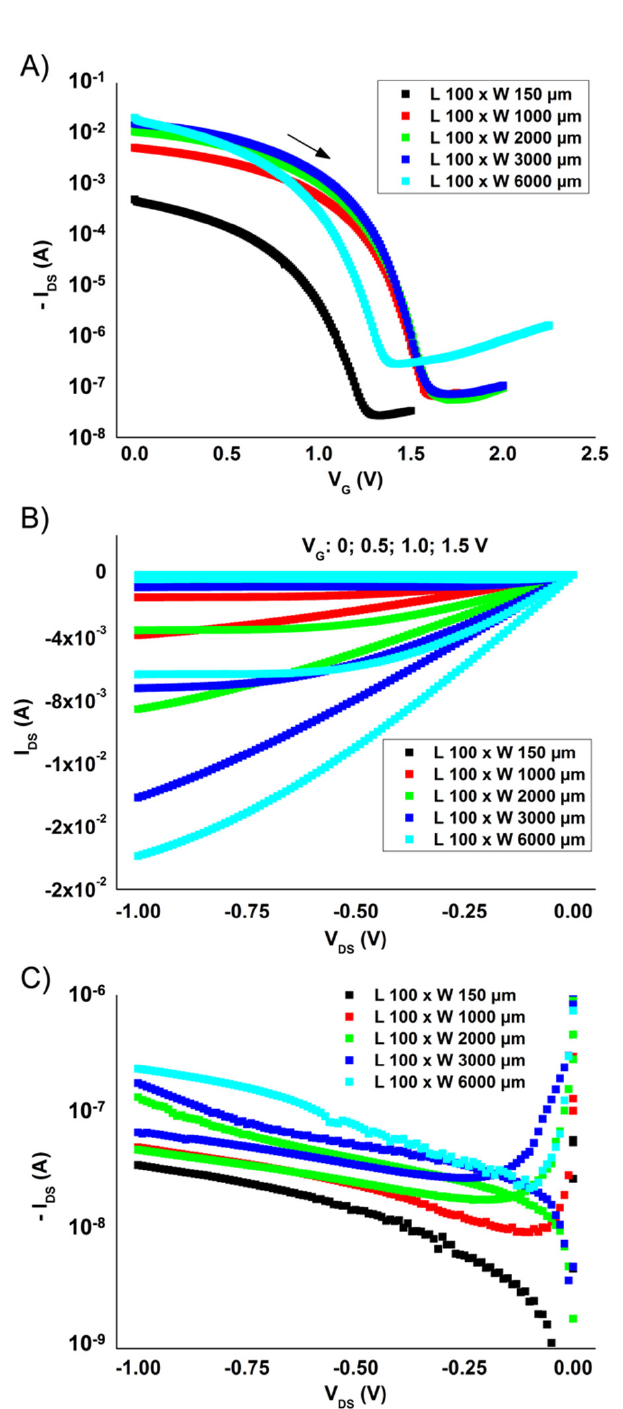
Figure 3. ( A ): The transfer characteristics (forward sweep direction, V D = − 1 V) of the five OECT channel widths being evaluated. The narrowest channel clearly resulted in the lowest current throughput and switching voltage, which are both advantageous from the points of view of power consumption and operational lifetime. The wider channels resulted in higher current throughputs suitable for stimulation application. The interdigitated 6 mm wide channel showed a relatively low switching voltage; however, its increased leakage current level was considered disadvantageous. ( B ): The output characteristics for the same OECTs are shown in this panel upon subsequently applying gate voltages of 0, 0.5, 1.0 and 1.5 V to each OECT. ( C ): The graphs are based on the same data already shown in the middle panel, but here the minimum current levels are shown upon applying V G = 1.0 or 1.5 V.